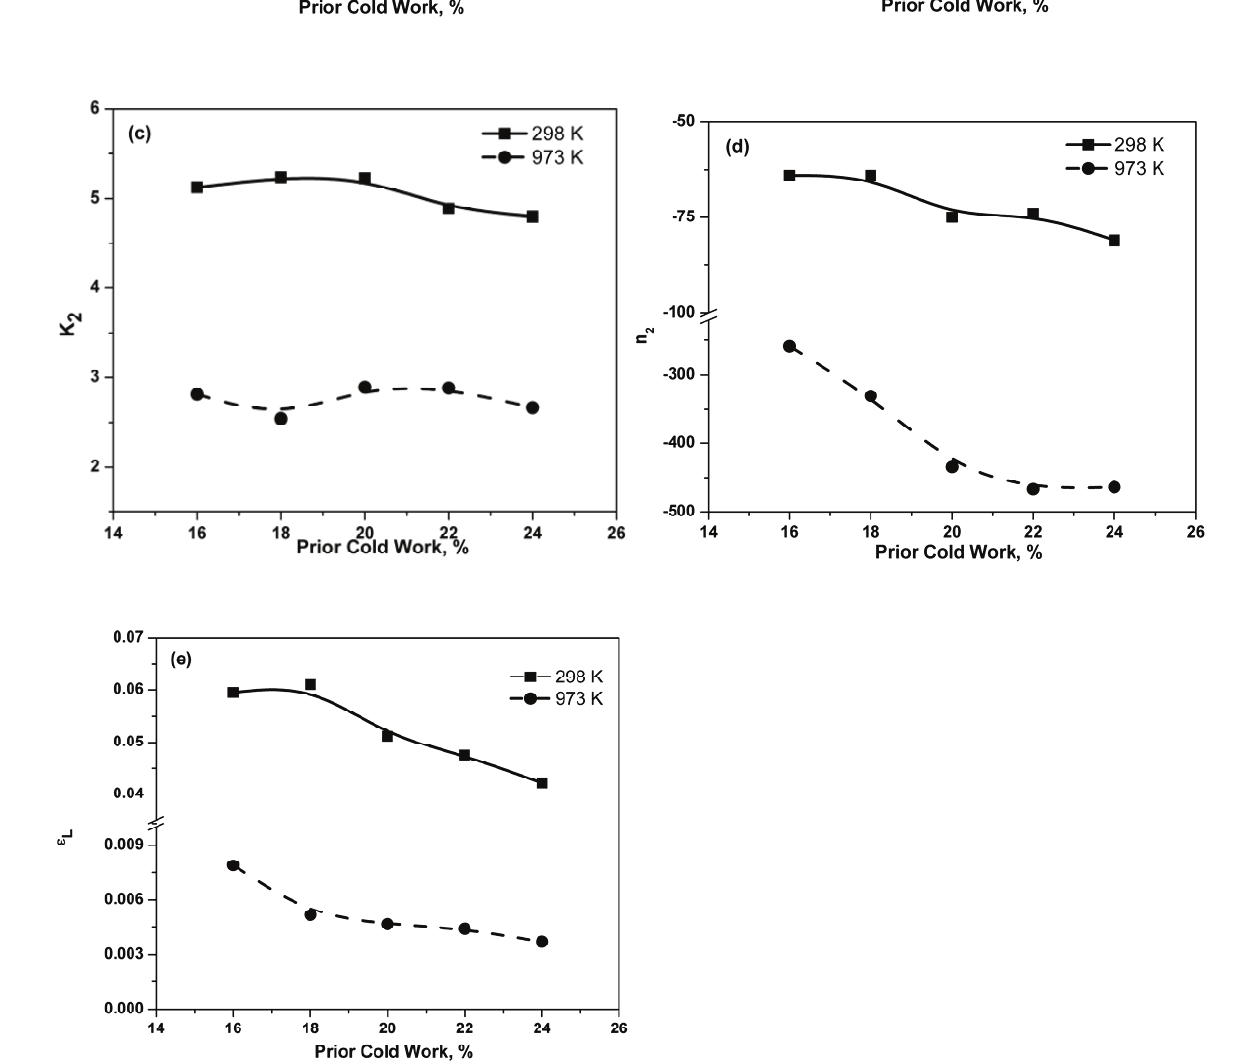
Figure 4. Variation of Ludwigson parameter (a) K 1 (b) n 1 (c) K 2 (d) n 2 (e) " L with PCW at teat temperatures at 298 K and 973